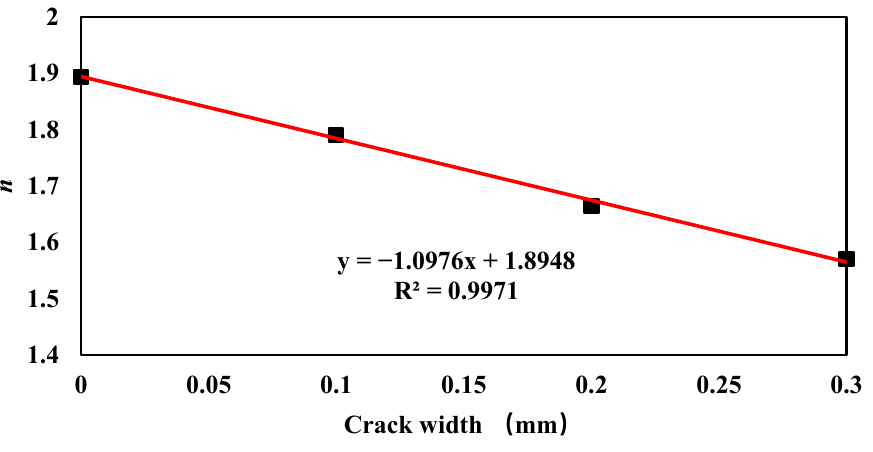
Figure 9. Relationship between n and crack width w .